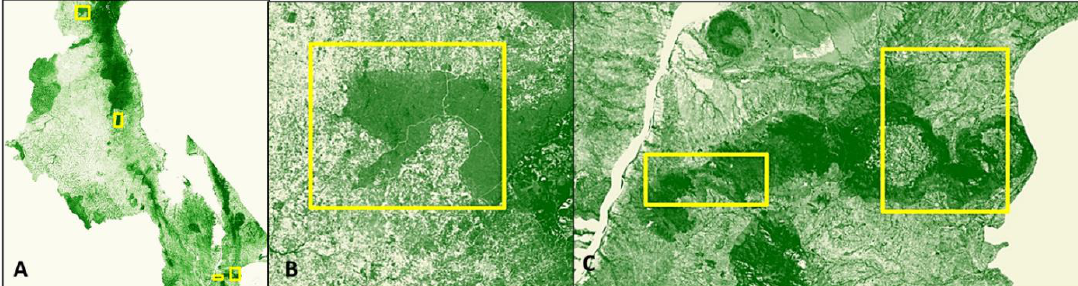
Figure A2. Location of test sites. Yellow boxes outline the coverage with VHR satellite data. ( A ) Reference map showing four test sites in Malawi. ( B ) The landscape in and around the Perekezi Forest Reserve, and the bottom inserts is ( C ) The landscape in and around the Liwonde Forest Reserve, segmented into east and west test sites.